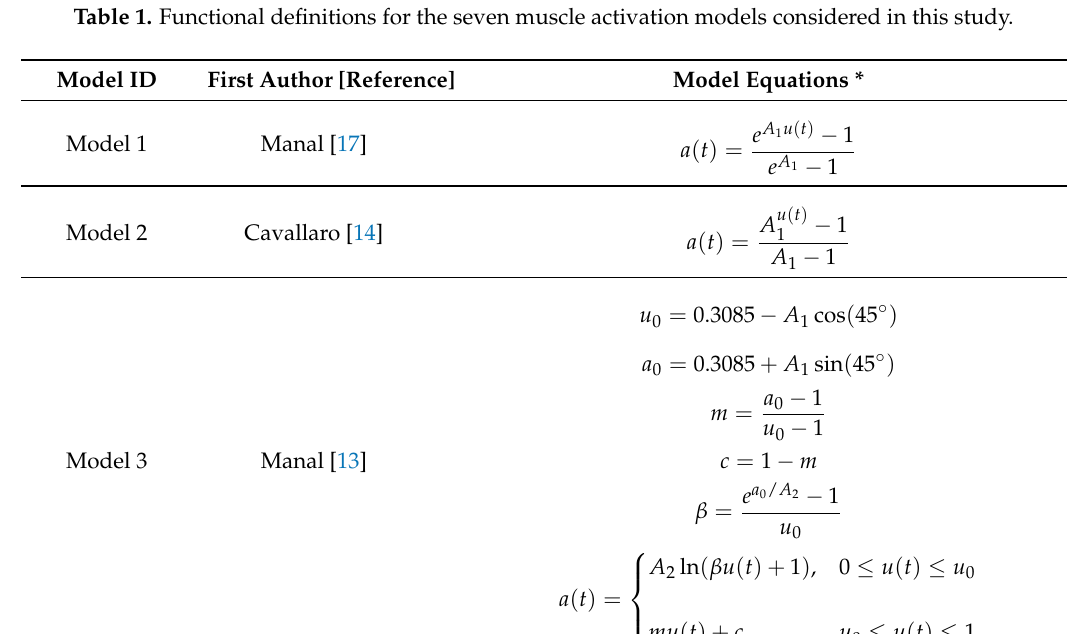
Table 1. Functional definitions for the seven muscle activation models considered in this